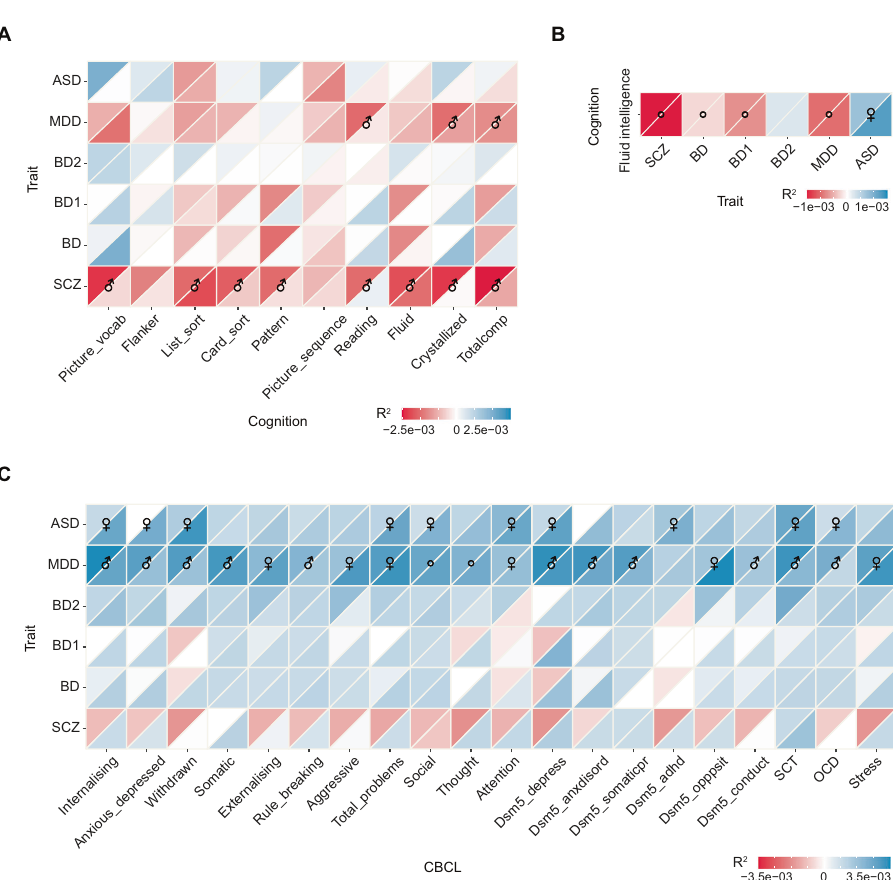
Fig. 2 Sex-speci fi c PRS effects for psychiatric disorders on cognitive functions and psychiatric behaviors. A , B Heat map showing effects of psychiatric disorder PRSs on cognitive functions in children and adults. C The effects of psychiatric disorder PRSs on psychiatric behaviors in children. The upper triangle indicates the observed partial R 2 for males, and the lower triangle indicates the observed partial R 2 for females. ♂ shows that the observed partial R 2 of males was signi fi cantly higher than that of the females, and ♀ represents that females have a higher partial R 2 . ○ shows the observed partial R 2 was signi fi cant, but there was no signi fi cant sex difference. Blue represents phenotypic positive correlation, and red represents negative correlation. SCZ schizophrenia, BD bipolar disorder, BD1 type 1 bipolar disorder, BD2 type 2 bipolar disorder, MDD major depressive disorder, ASD autism spectrum